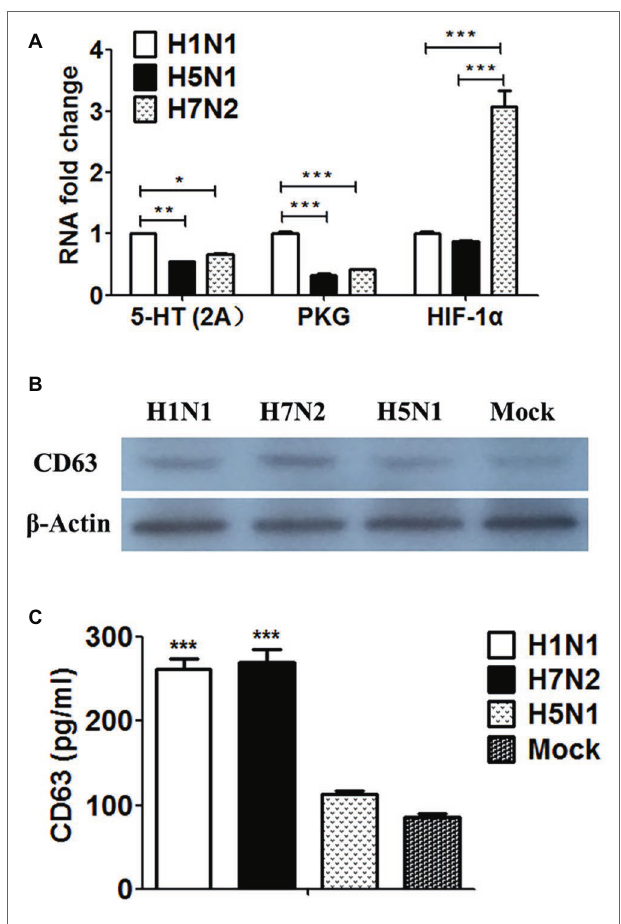
FIGURE 7 | The distinct of expressions of 5-HT, PKG, and HIF-1 as well as exosomes in P815 cells among three subtypes of IAVs. (A) The mRNA levels of 5-HT, PKG and HIF-1 in P815 cells following H1N1, H5N1, and H7N2 infection were determined by real-time PCR ( N = 3); * p < 0.05, ** p < 0.01, *** p < 0.001. (B) The protein levels of CD63 in P815 cells following H1N1, H5N1 and H7N2 infection were detected by western blotting. (C) The protein levels of CD63 in P815 cells following H1N1, H5N1, and H7N2 infection were quantitatively detected by ELISA ( N = 3); *** p <